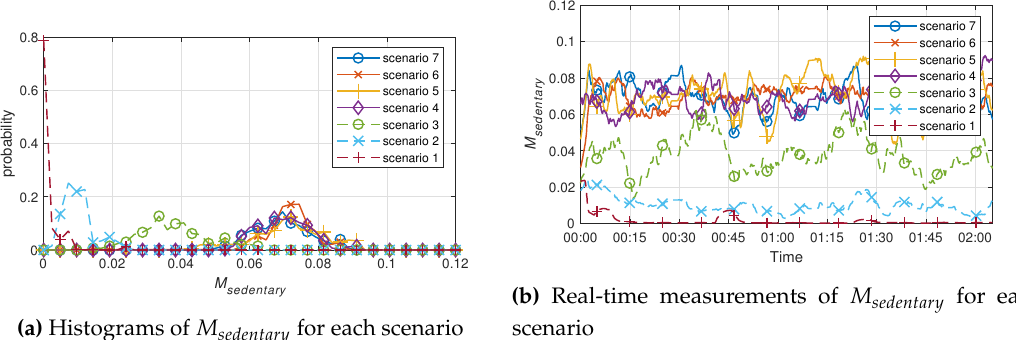
Figure 3. Experimental results of the sedentary movement index, M sedentary , for each scenario.